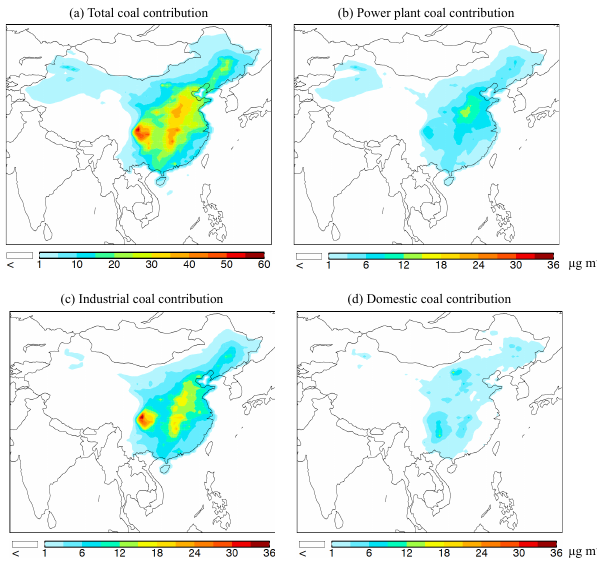
Figure 6. Annual mean contributions from coal